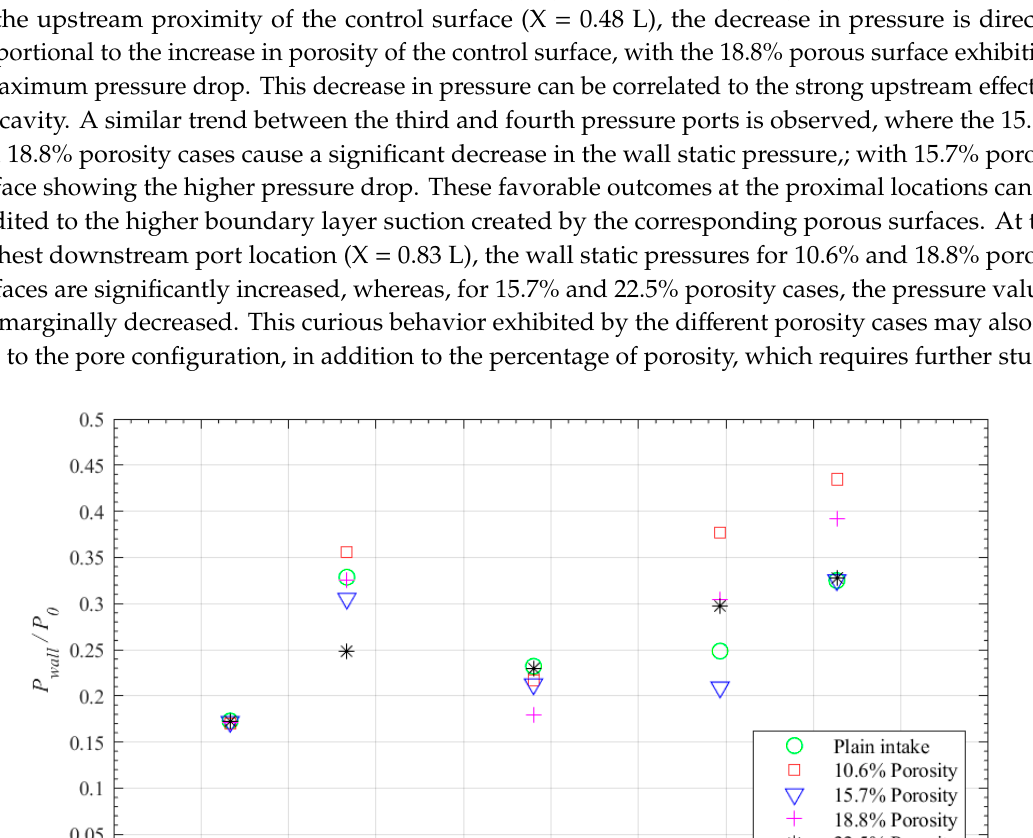
Figure 13. Static pressure variation along the intake-core due to wall ventilation at R c = 1.19. The wall static pressure variations for both uncontrolled and controlled intakes operating at R c = 1.22 are shown in Figure 14. At the second port (X = 0.27 L), the large pressure amplitudes are observed for all the tested porosity cases, except for the 22.5% surface porosity, where a noticeable decrease in pressure is witnessed. Here, the uncontrolled and wall-ventilated intakes (with an exception of 22.5% porosity) become unstart with the formation of either an attached normal shock or a detached bow-shock at the isolator-entry. In fact, the 22.5% perforated surface produces enough suction, which subsequently leads to a reduced boundary layer height. This, in turn, controls the